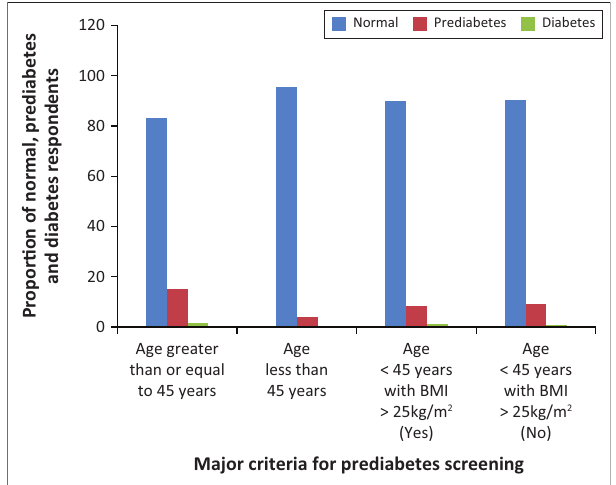
FIGURE 3: Proportion of missed prediabetes and diabetes diagnosis based on the major criteria.